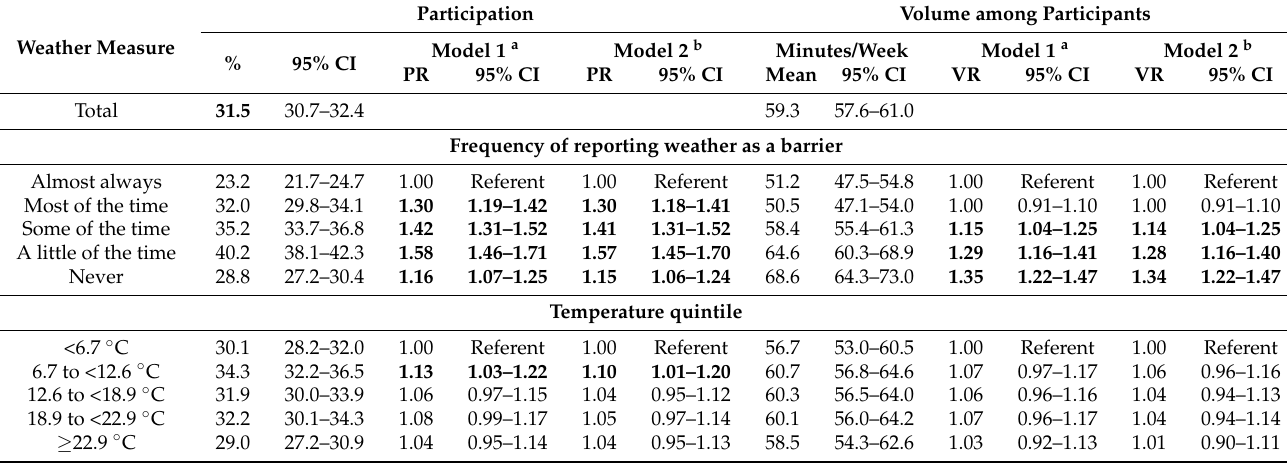
Table 2. Prevalence and volume (among participants) of transportation walking by weather